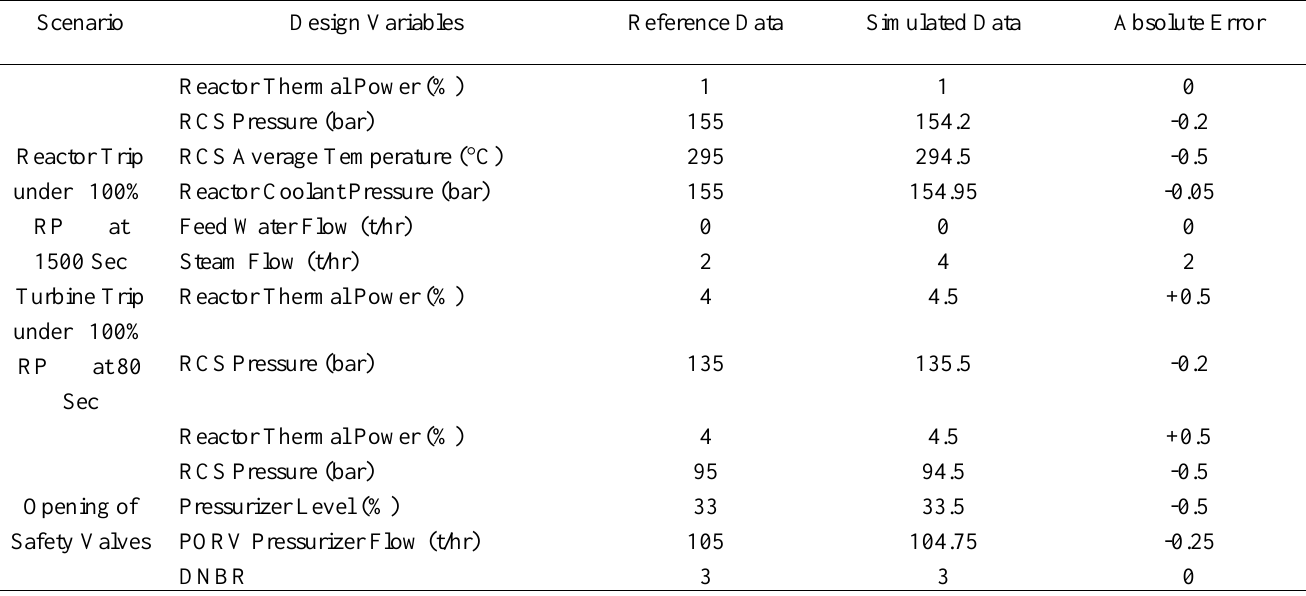
Comparison of Simulated and Reference Data under abnormal and severe conditions Scenario Design Variables Reference Data Simulated